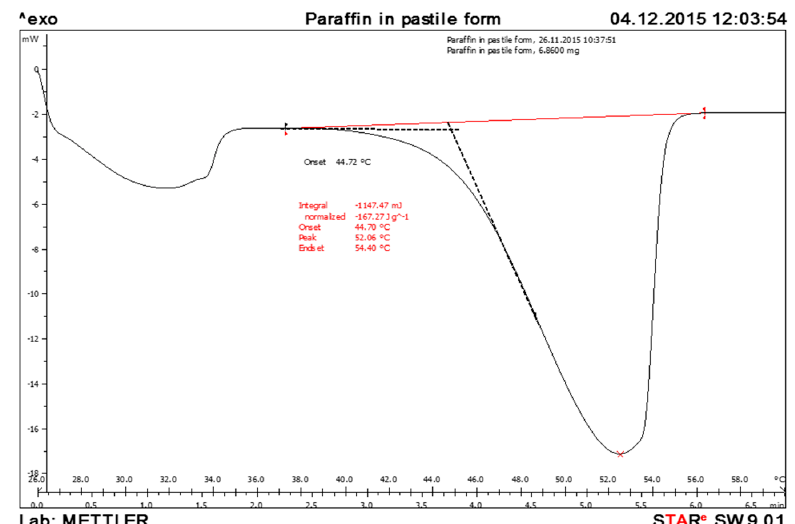
Figure A1. Paraffin DSC test curve.